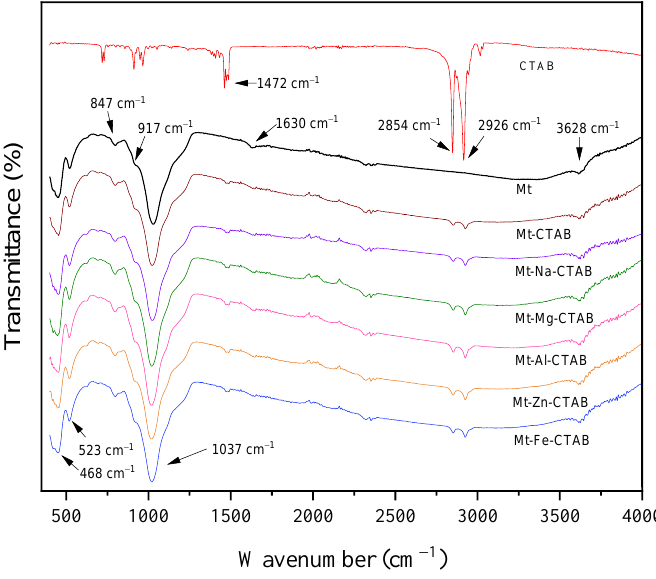
Figure 1. FTIR spectra of CTAB and CTAB-modified Mt.